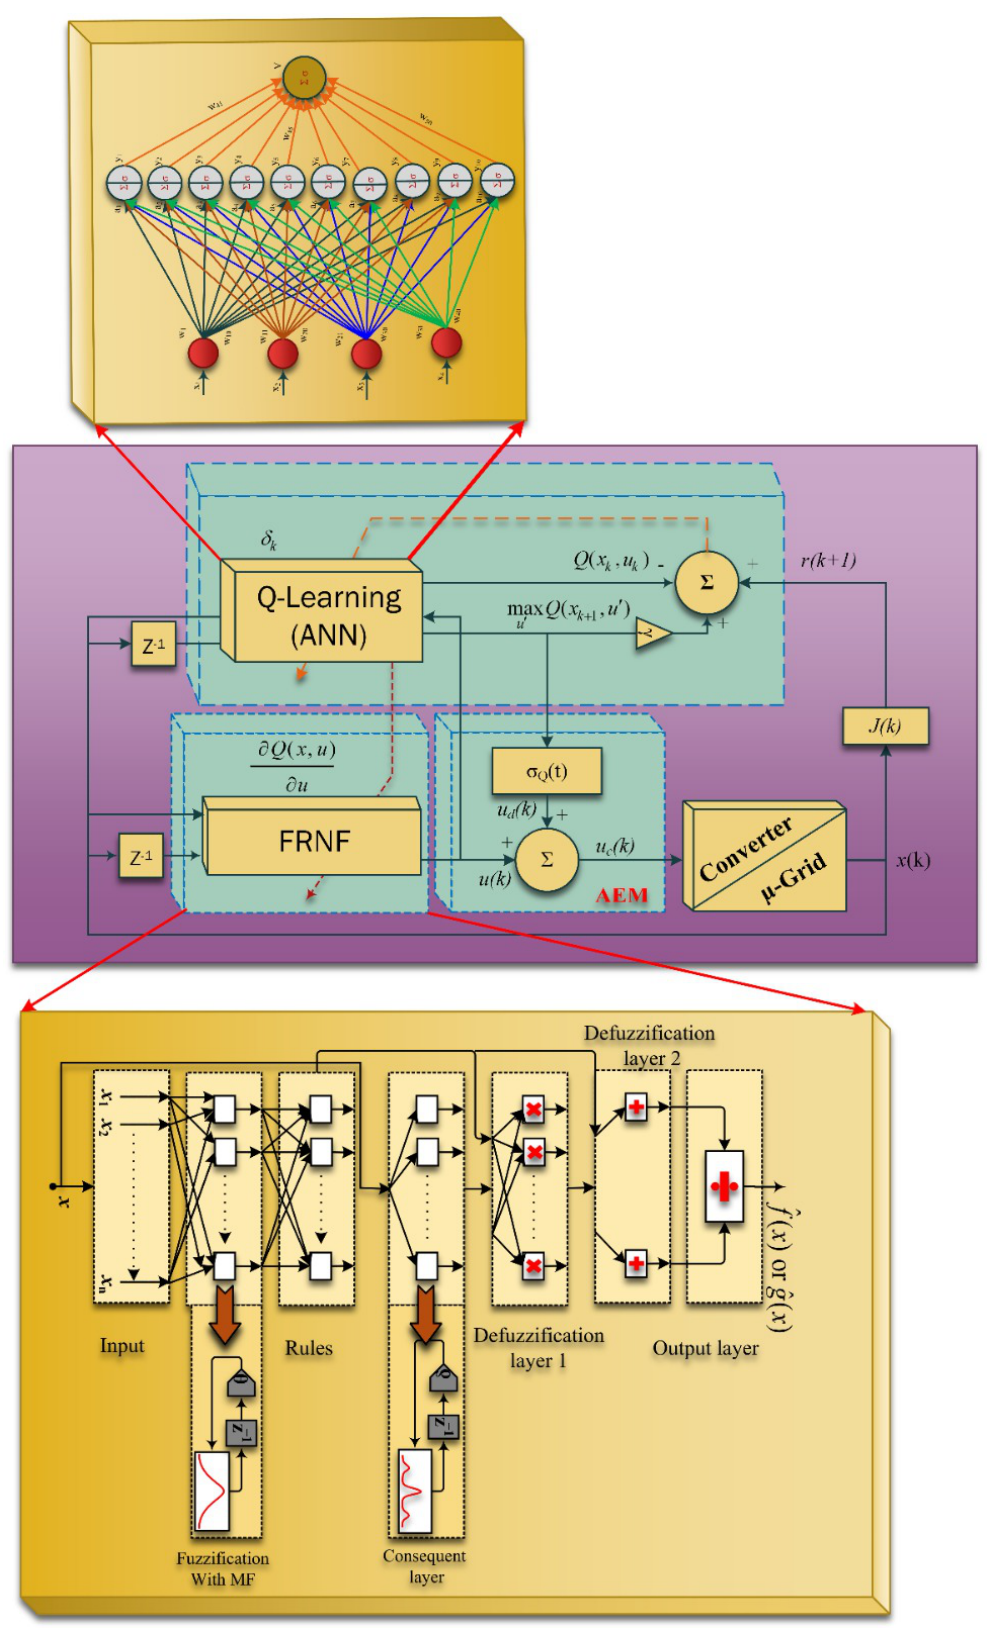
Figure 3. Neuro Network Q-learning-based full recurrent adaptive NeuroFuzzy internal